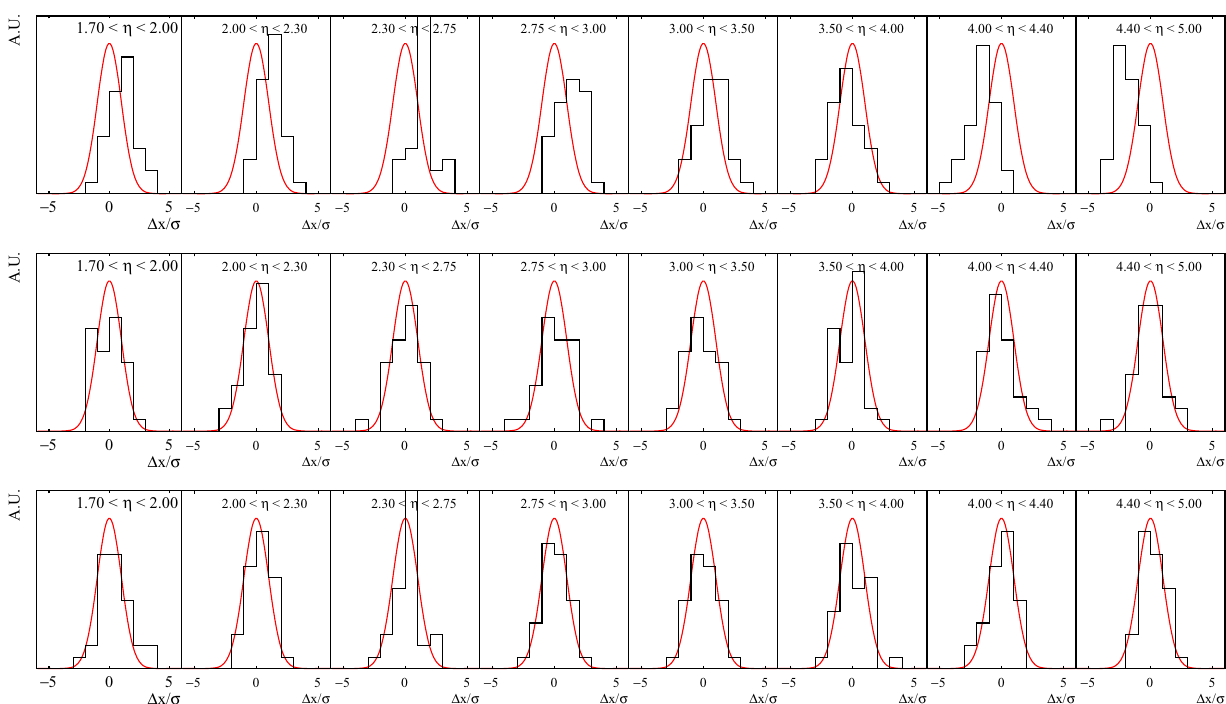
Fig. 3 The distribution of the difference between the measured Δ x values calculated with the pseudomass method and the expectation ( Δ x = 0 μ m) divided by the uncertainty of the measured parameter